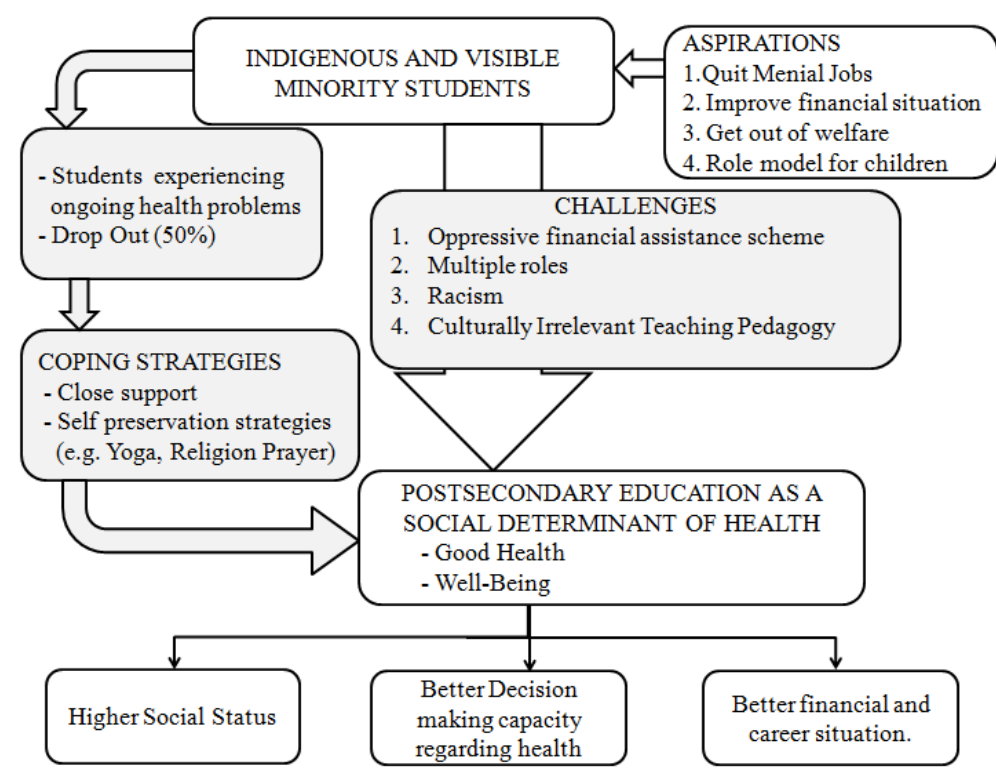
Figure 1. Aspirations, challenges and health perspectives of postsecondary students from LIIVM